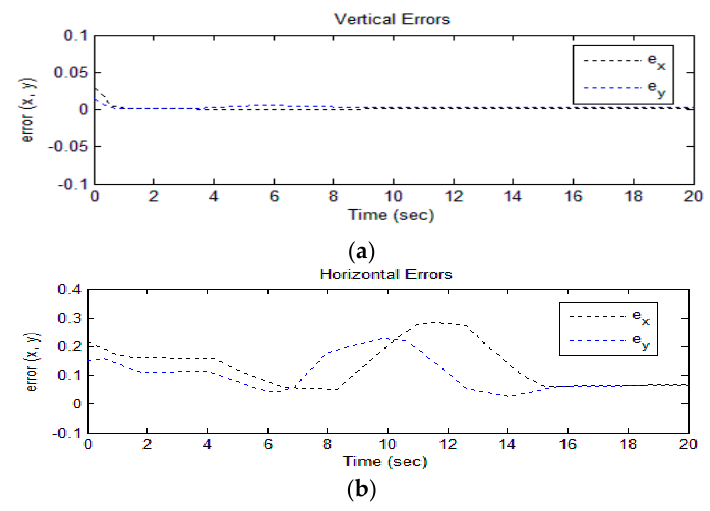
Figure 9. ( a ) Vertical errors of trajectory tracking in the x and y directions; ( b ) horizontal errors of trajectory tracking in the x and y directions. Aerospace 2017 , 4 , 3